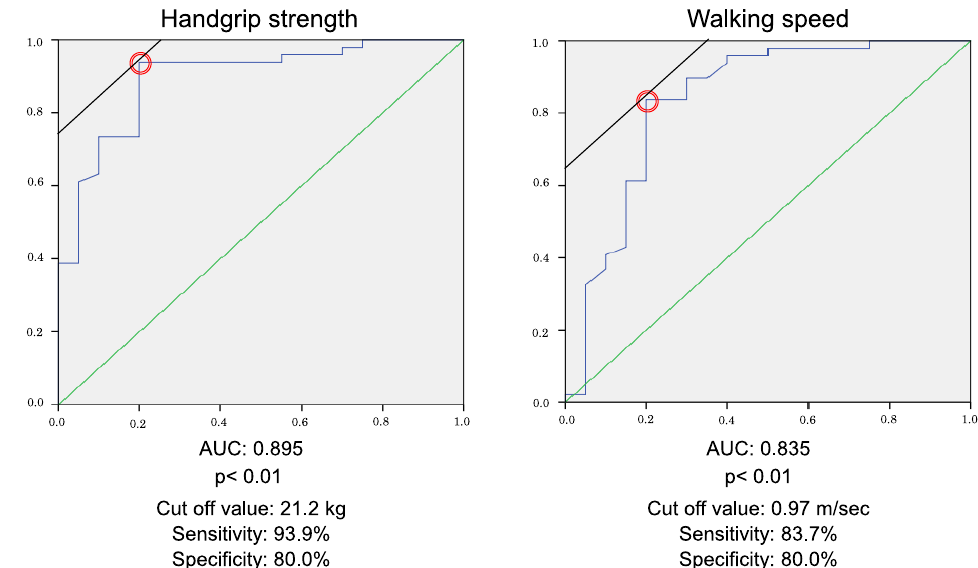
Figure 1 Receiver-operating characteristic curves of handgrip strength and walking speed for predicting the presence of